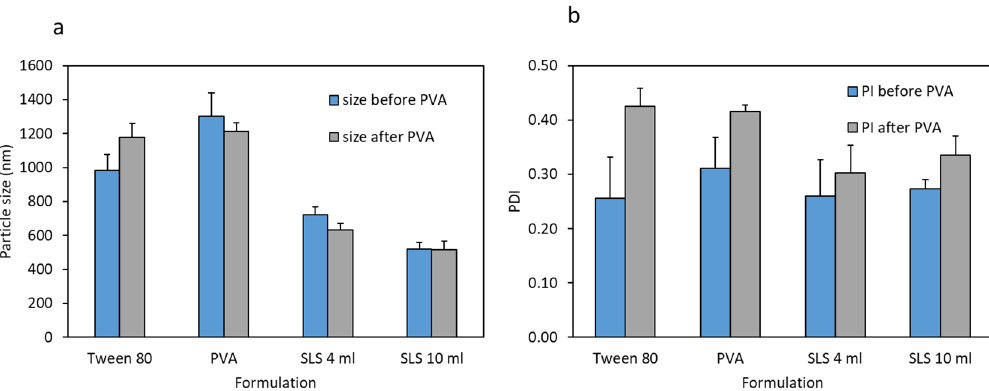
Figure 3. ( a ) Particle size of CU-NS for different surfactants in aqueous solutions before and after mixing with poly(vinylalcohol) (PVA) solutions; ( b ) Polydispersity of CU-NS for different surfactants in aqueous solutions before and after mixing with PVA. Means + S.D., n = 3.